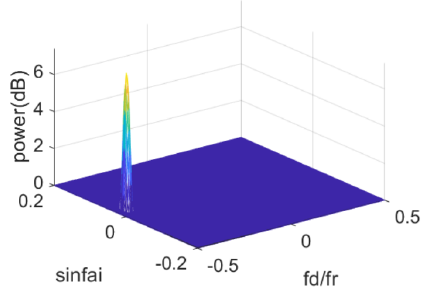
Figure 17. The output result by